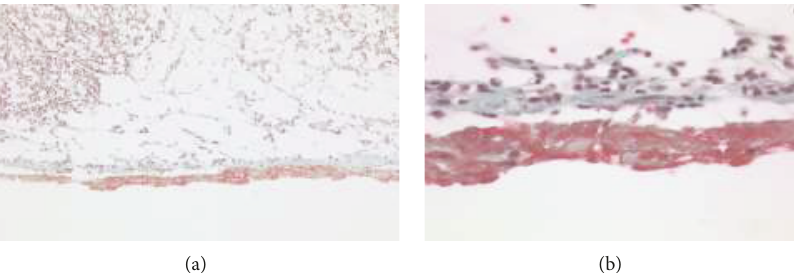
Figure 6: Goldner ’ s trichrome histological staining method at 20x magni fi cation (a) and 80x magni fi cation (b) exhibiting the tumor in the upper layer, fi brosis in the middle green layer, and thrombosis in the lower red layer. Between the fi brotic band and the thrombosis, there are identi fi able gut endothelial cells from the VCI.